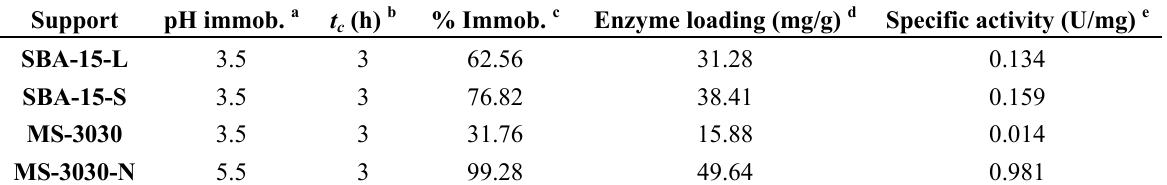
Table 1. Laccase immobilization characteristics and catalytic results for initial amount of enzyme solution of 50 mg/g